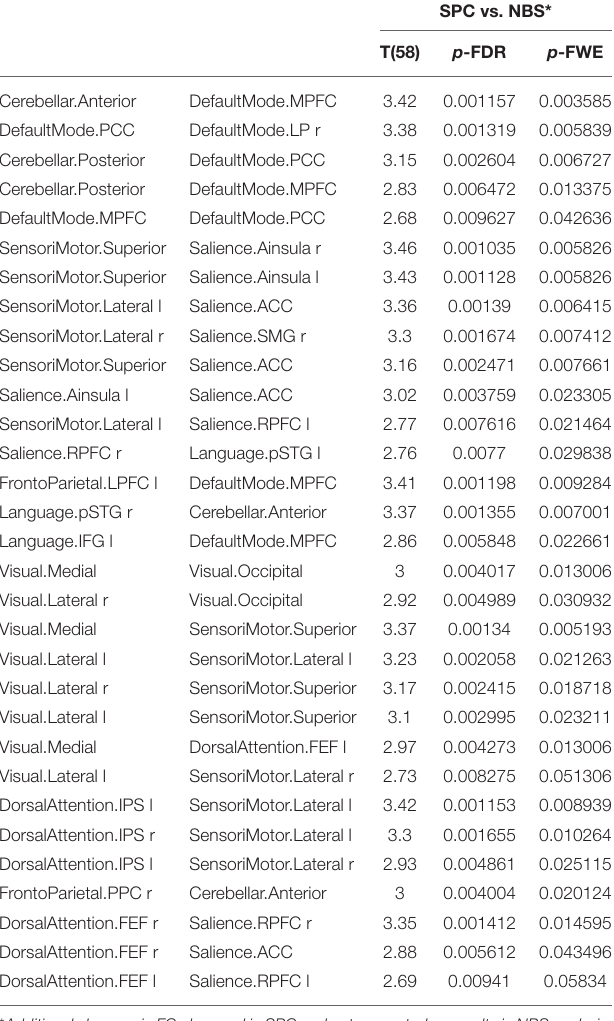
TABLE 7 | The increased functional connectivity in older women observed only in NBS analysis, not found in SPC method.